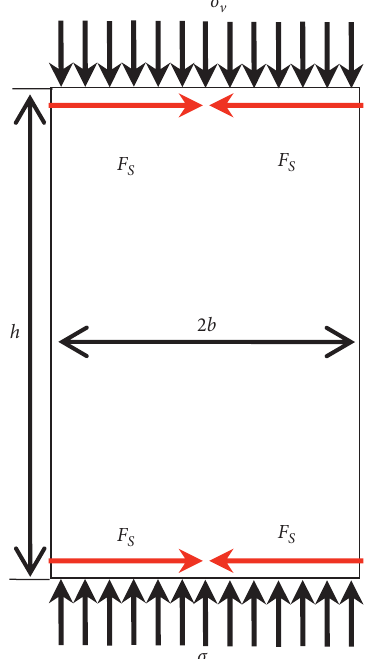
Figure 2: Cylindrical coordinate system model of rock